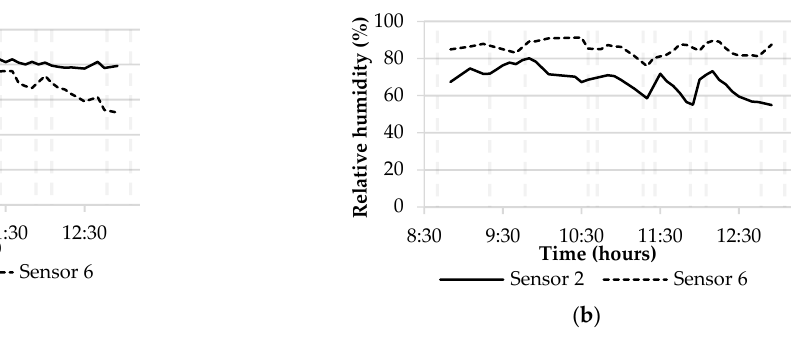
Figure 14. Readings of sensor 2 and sensor 6 for temperature ( a ) and relative humidity ( b ).